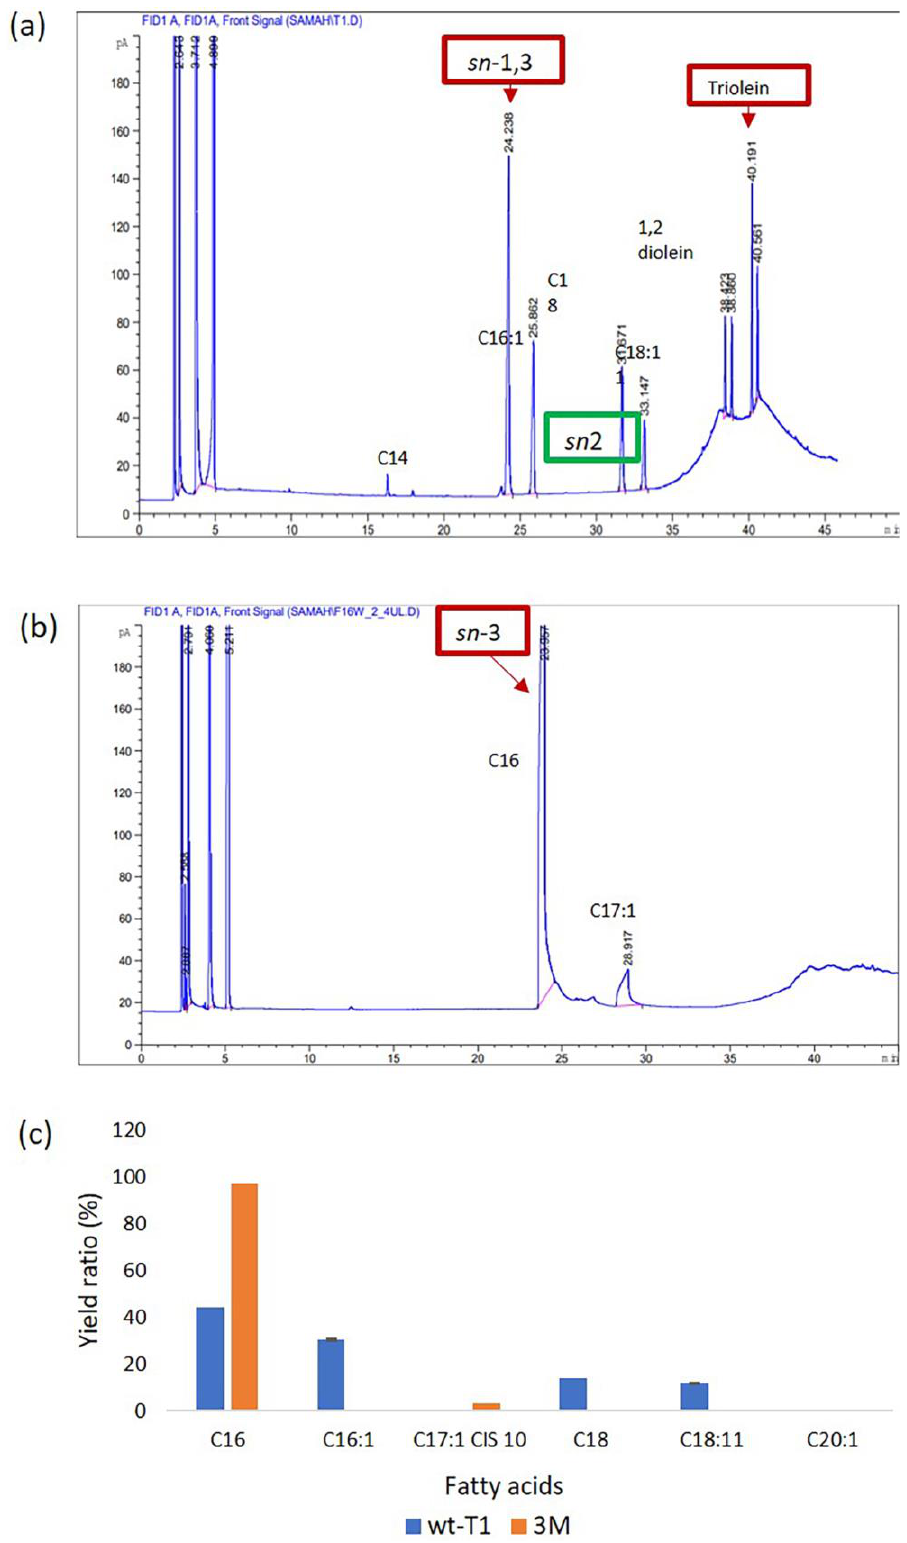
Figure 4. Gas chromatography flame ionisation detector (GC FID) analysis for ( a ) wt-T1 lipase and ( b ) for 3M lipase. The acylglycerol position is highlighted by the red box. ( c ) Different fatty acid yields in percentages produced by wt-T1 and 3M lipases. The experiment was conducted using palm stearin as a substrate and single-factor ANOVA analysis with n = 3.